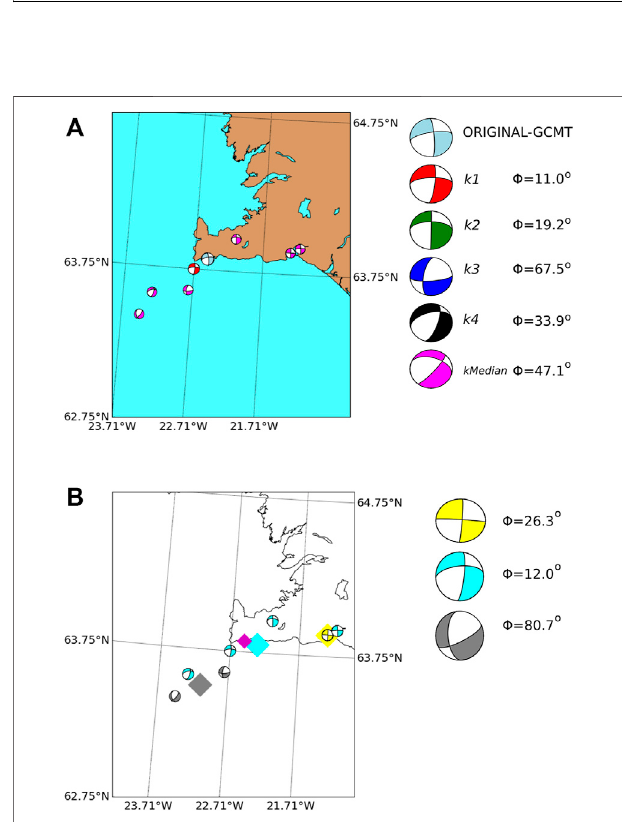
FIGURE 11 | Same as Figure 8 for an M w = 4.8 Icelandic earthquake (see Table 3 ).